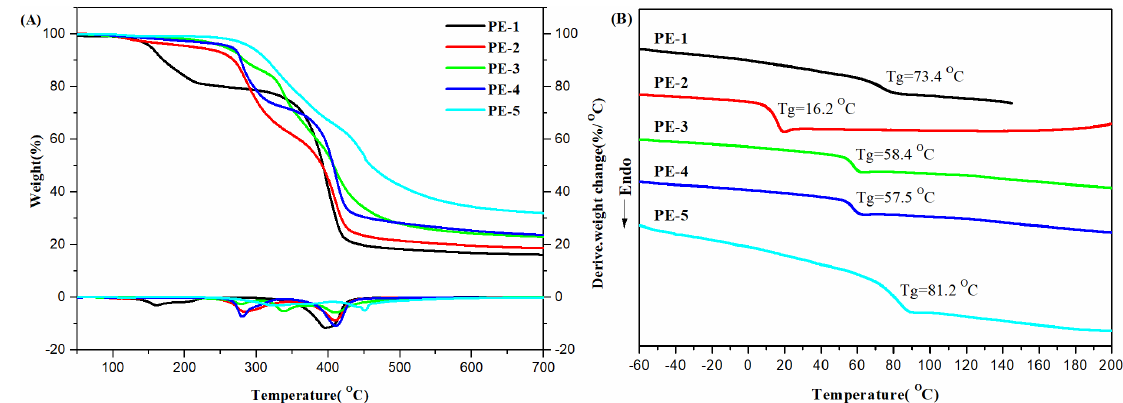
Figure 4. TGA curves ( A ) and differential scanning calorimetry (DSC) traces ( B ) of PEs.